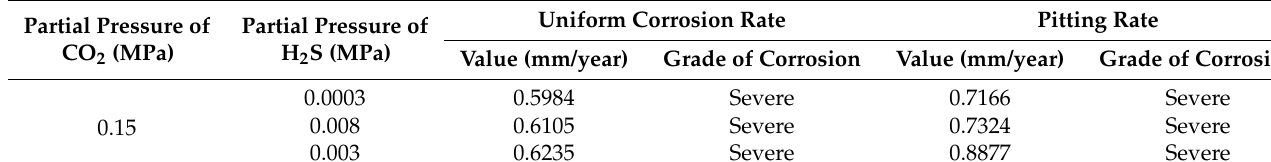
Figure 2. Scanning electron micrographs of pits (×25 times) ( a ) P CO ( c ) P CO = 0.45 MPa. 2 2 Table 8. Experimental results of experimental conditions 2.